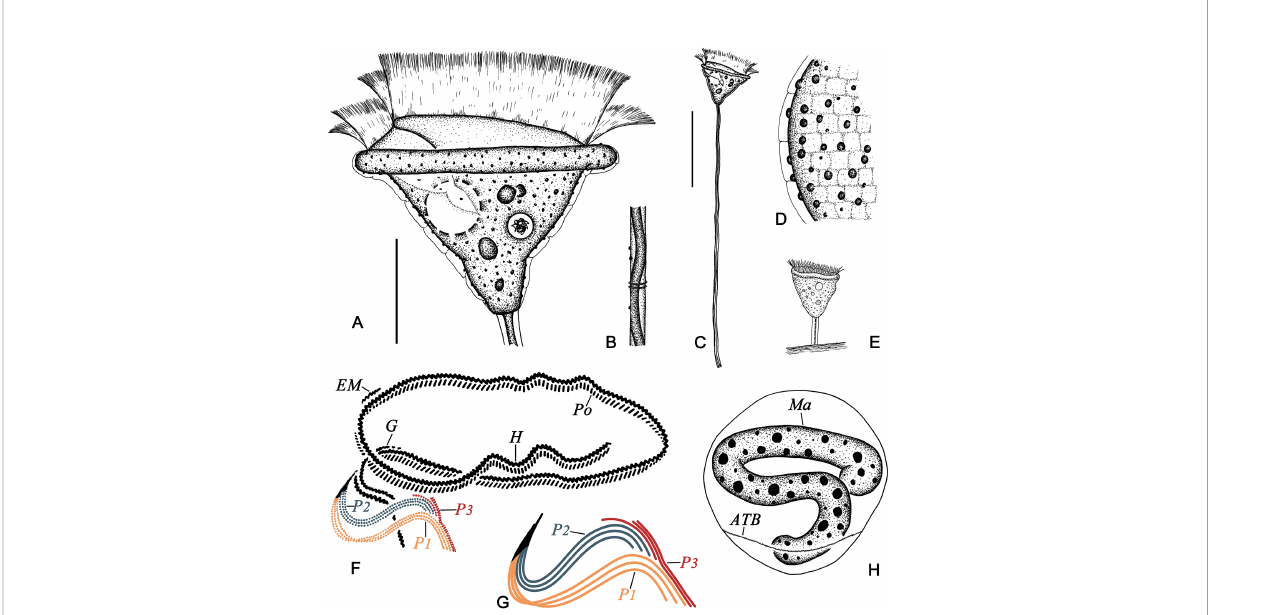
FIGURE 5 Pseudovorticella verrucosa from life (A – E) and after protargol staining (F – H) . (A) Typical shape of the zooid. (B) Details of the stalk and spasmoneme. (C) A complete individual with stalk and zooid. (D) Details of the pellicle. (E) The original illustration from Dons (1915). (F) Oral ciliature. (G) Arrangement of the three infundibular polykineties. (H) The macronucleus. ATB, aboral trochal band; EM, epistomial membrane; G, germinal kinety; H, haplokinety; Ma, macronucleus; Po, polykinety; P1 – 3, infundibular polykinety 1 – 3. Scale bars: 20 m m (A) and 70 m m (C)